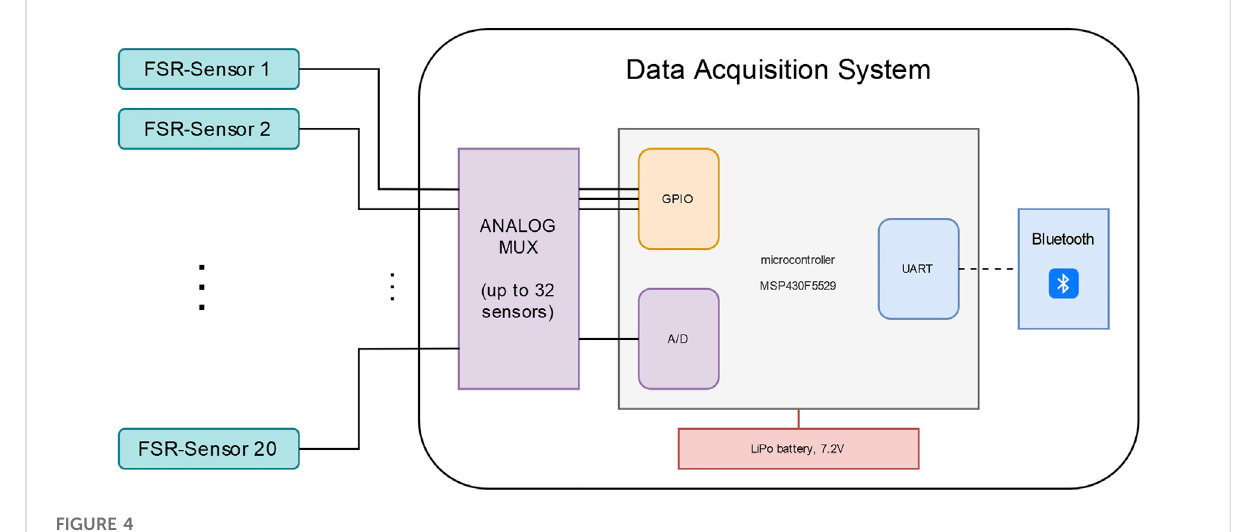
FIGURE 4 DAQ system for FMG: overview of the major components.